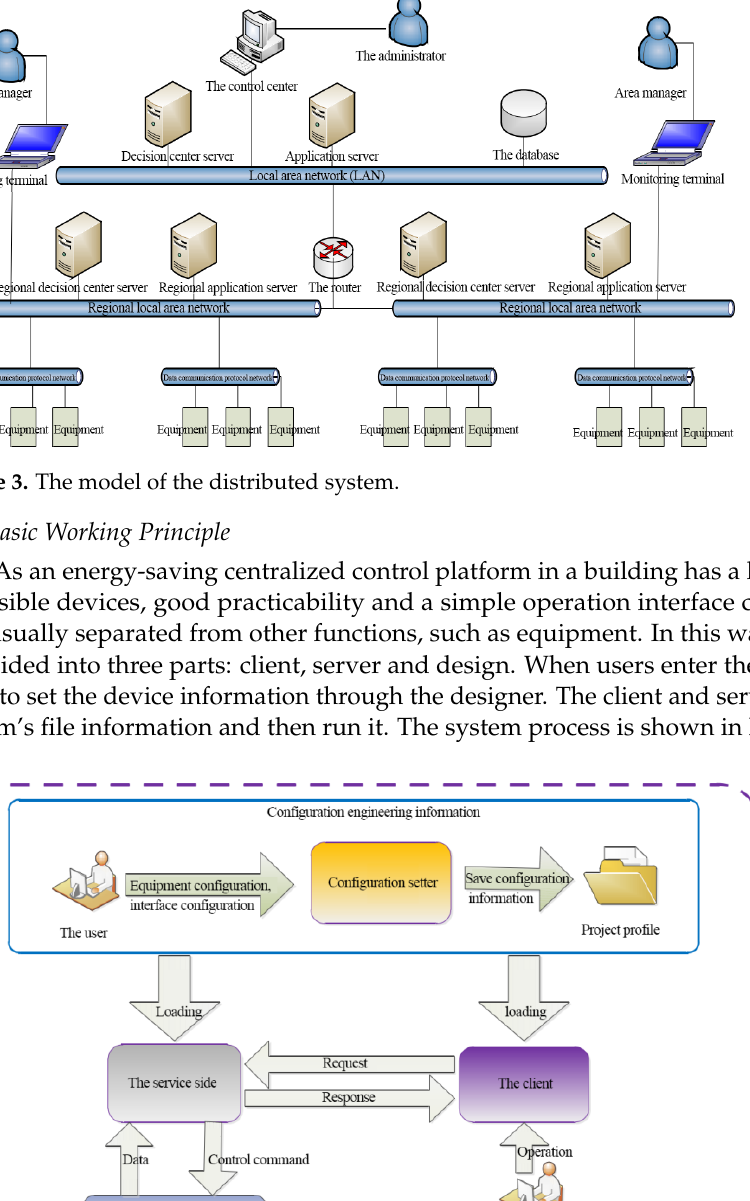
Figure 2. The structure of the distributed lighting control system.